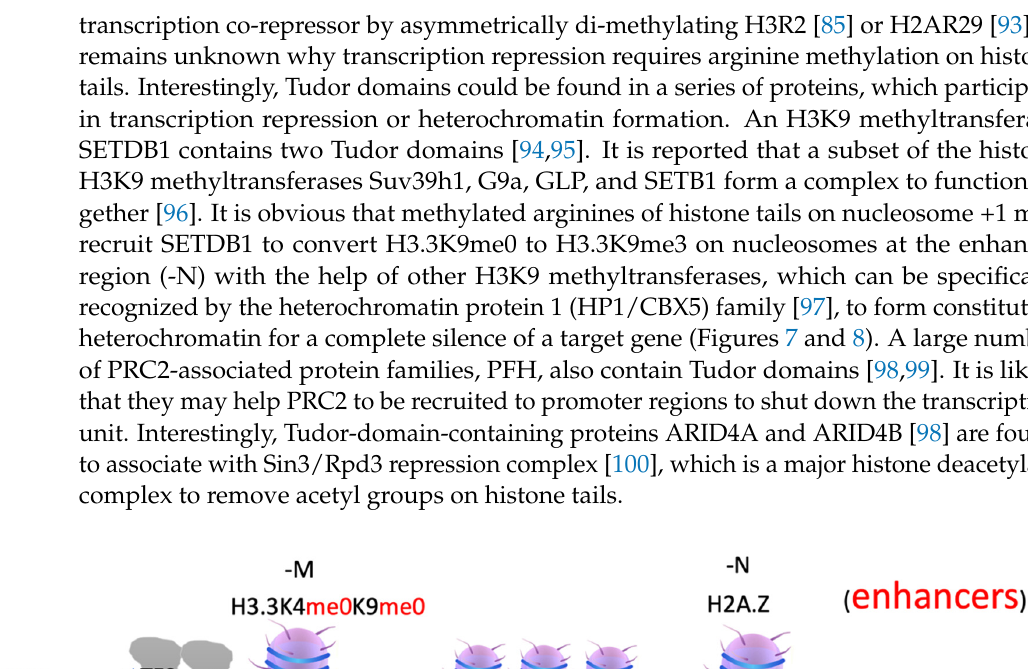
Figure 8. A model of how heterochromatin is formed by HP1 after methylation of H3K9. H3.3K9me3 will recruit HP1protein to form heterochromatin. HP1, heterochromatin protein 1. In summary, several Tudor-domain-containing transcription cofactors that are in- volved in transcription repression could be recruited by arginine-methylated histone tails on +1 nucleosomes of stimulation-regulated genes, with correspondent repressing com- plexes such as Sin3-containing histone deacetylase complex, which remove acetyl groups on nucleosomes at enhancers, or PRC2 complex, which builds facultative heterochromatin to convert an active transcription unit back to a repressive unit for a later reactivation, a very popular action after zygote activations during embryonic development. However, data on direct and specific interactions between these Tudor domains of cofactors and arginine-methylated histone tails are still lacking. This could be a future exciting field to explore. 5. The Ubiquitous Arginine Methylation and Potential Final Destination Proteomic analysis of the status of arginine methylation reveals an astonishing fact— namely, that arginine methylation is similar to those of phosphorylation and ubiquitina- tion; it is ubiquitous (Figure 1) [15]. It is very well established that both phosphorylation and ubiquitination are reversible, which are achieved by either large family members of phosphatases [101] or a large group of deubiquitinating enzymes [102]. However, the hunting of arginine demethylases is not very successful so far. It is of interest to know whether it exists in vivo and, most importantly, the exact biological consequence of the